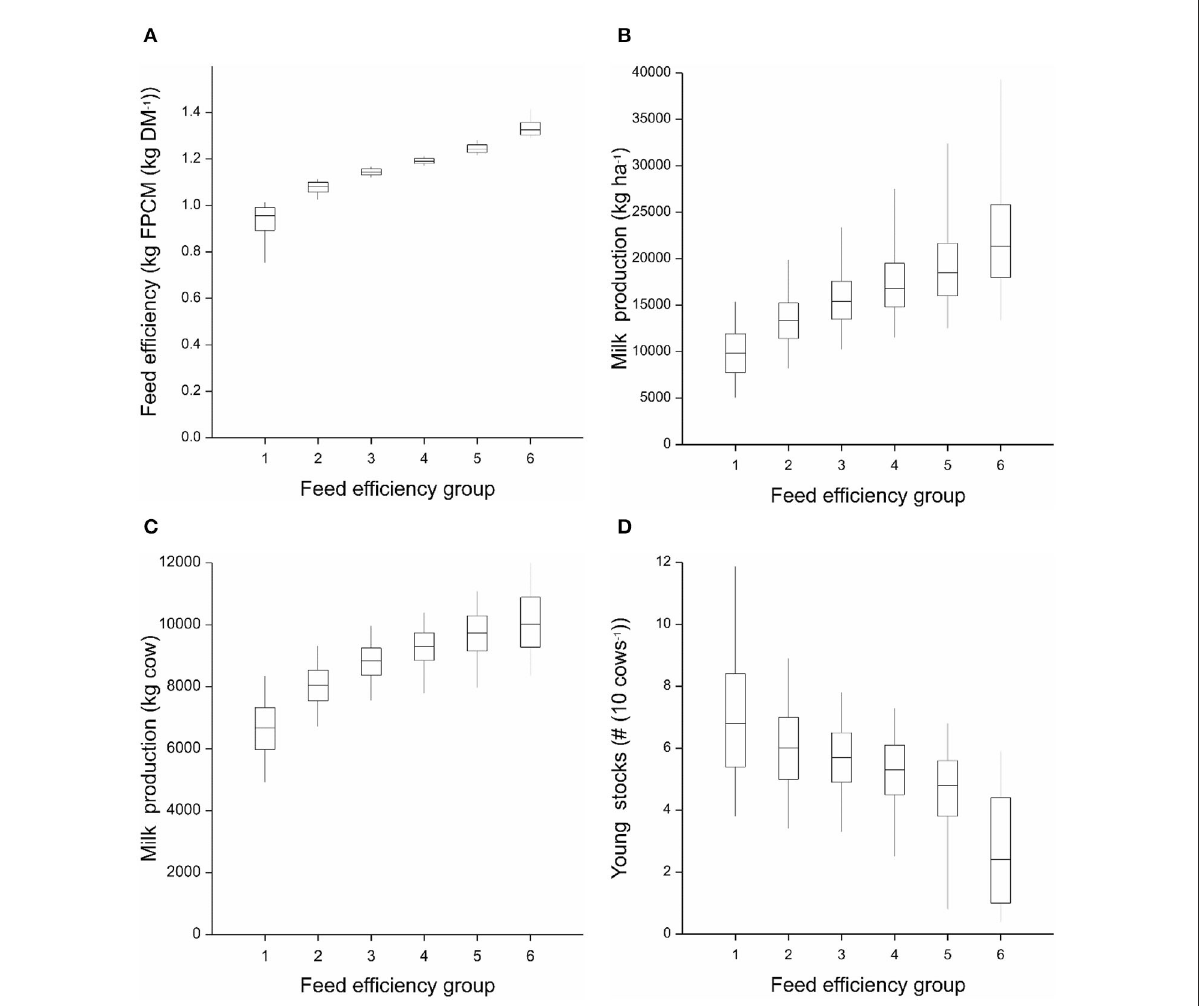
FIGURE1 Boxplots of indicator values per group of farms. (A) Feed efficiency expressed in kg feed dry matter (DM) needed per kg milk produced; (B) milk production per ha of farmland; (C) milk production per cow; and (D) number of young stock per 10 cows. The 12.770 farms were ordered in descending order of feed efficiency (expressed in kg feed DM needed per kg milk produced) and then divided in six ‘Feed efficiency groups’ according percentile values (0–10; 10–30; 30–50; 50–70; 70–90; and